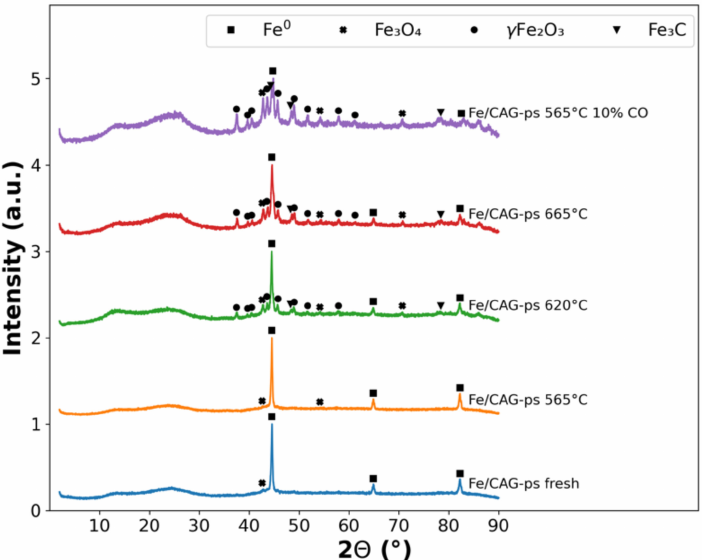
Figure 9. XRD pattern of fresh and spent Fe/CAG-ps during naphthalene